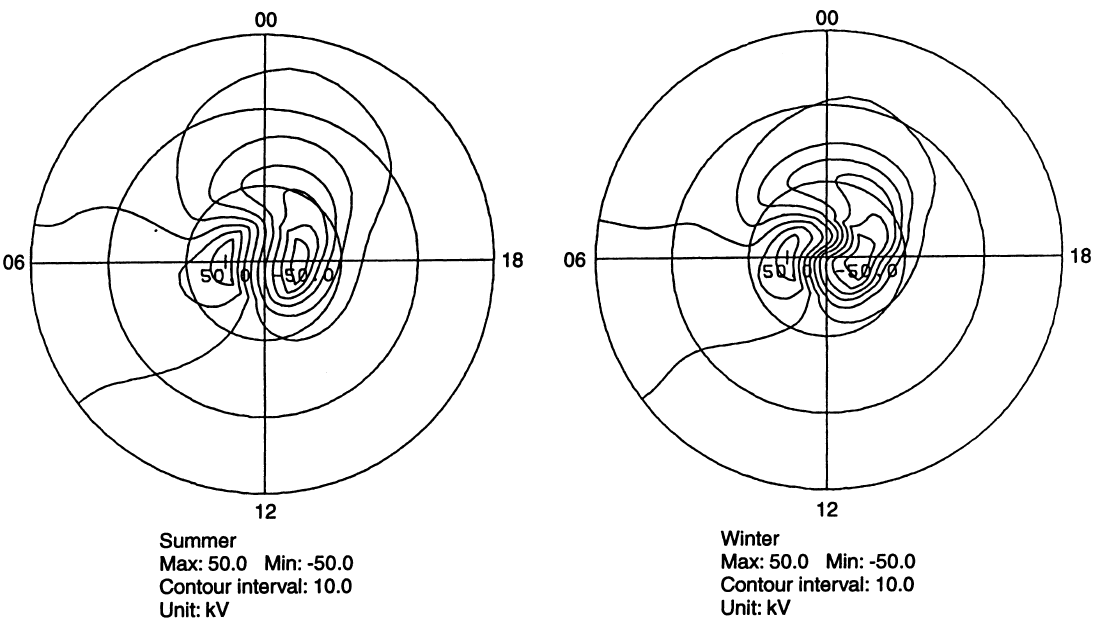
Fig. 9. Potential contours in the summer ( left ) and winter ( right ) hemispheres for the voltage generator. Circles are 60 (cid:176) and 30 (cid:176) latitudes and the equator from the inside, respectively. The interval of the potential contours is 10 kV